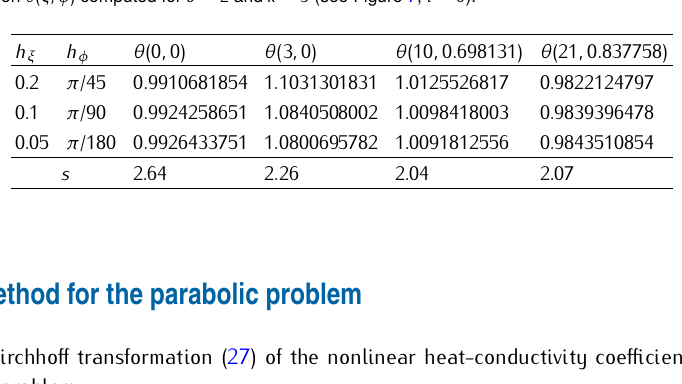
Table 1. Self-similar function θ ( ξ,φ ) computed for σ = 2 and k = 3 (see Figure 7, t = 0